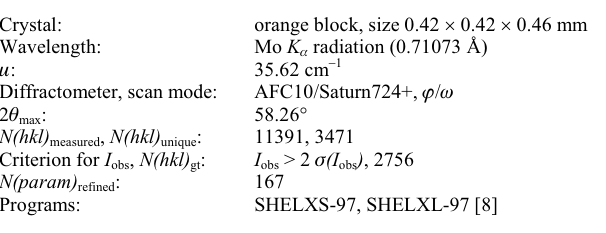
Table 1. Data collection and handling.